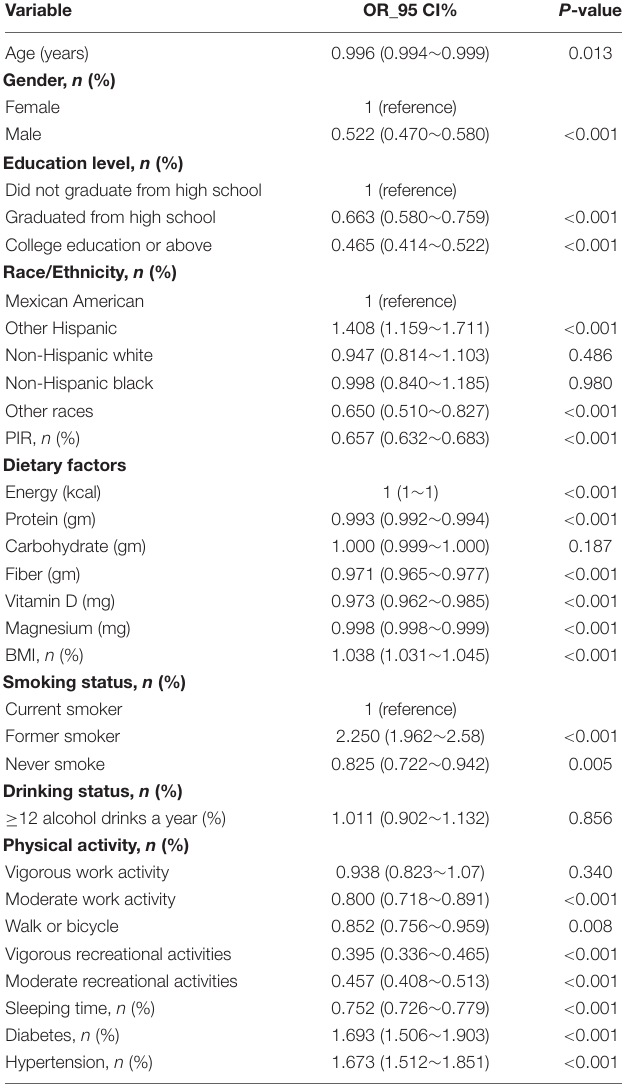
TABLE 2 | Association of covariates and depression risk. D, and magnesium were associated with the risk of depression ( Table 2 ). The findings of the multifactorial logistic regression analysis are shown in Table 3 . In the unadjusted model, dietary fiber intake was shown to be inversely related to the risk of depression (OR, 0.97; 95% CI, 0.97–0.98). Results were similar after adjusting for age and gender (OR, 0.98; 95% CI, 0.97– 0.98). After adjusting for other possible confounders,